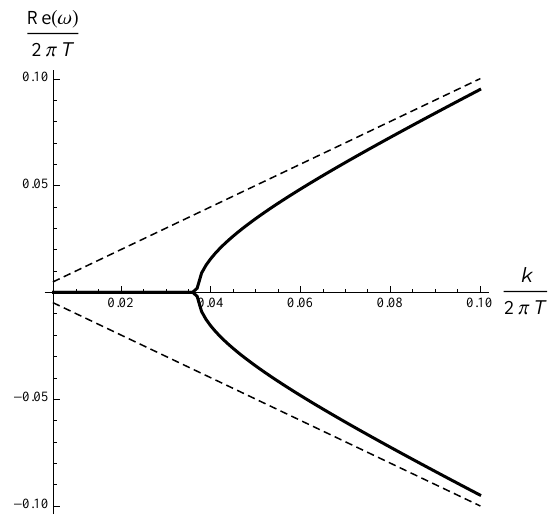
Figure 3: Movement of real part of diffusion damped plasma oscillation poles as a function of momentum = 1000. For k < k k , with r (cid:63) π (cid:63) both poles have zero real part; for k T imaginary axis, approaching a relativistic linear photon dispersion (dotted line) ω ∼ k at large k